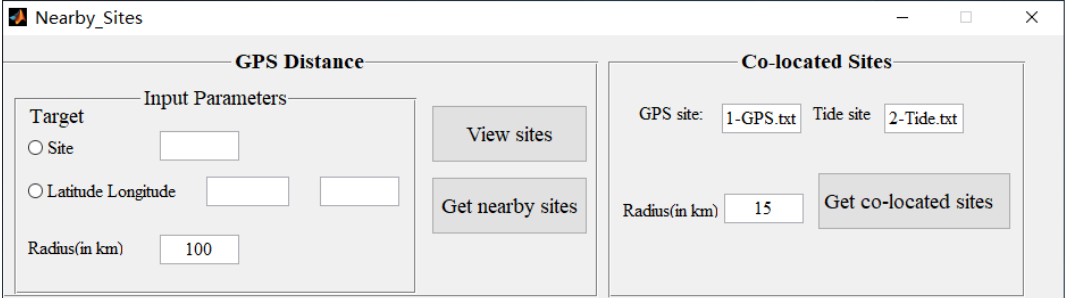
Figure 9. Searching for nearby sites and finding co-located sites.